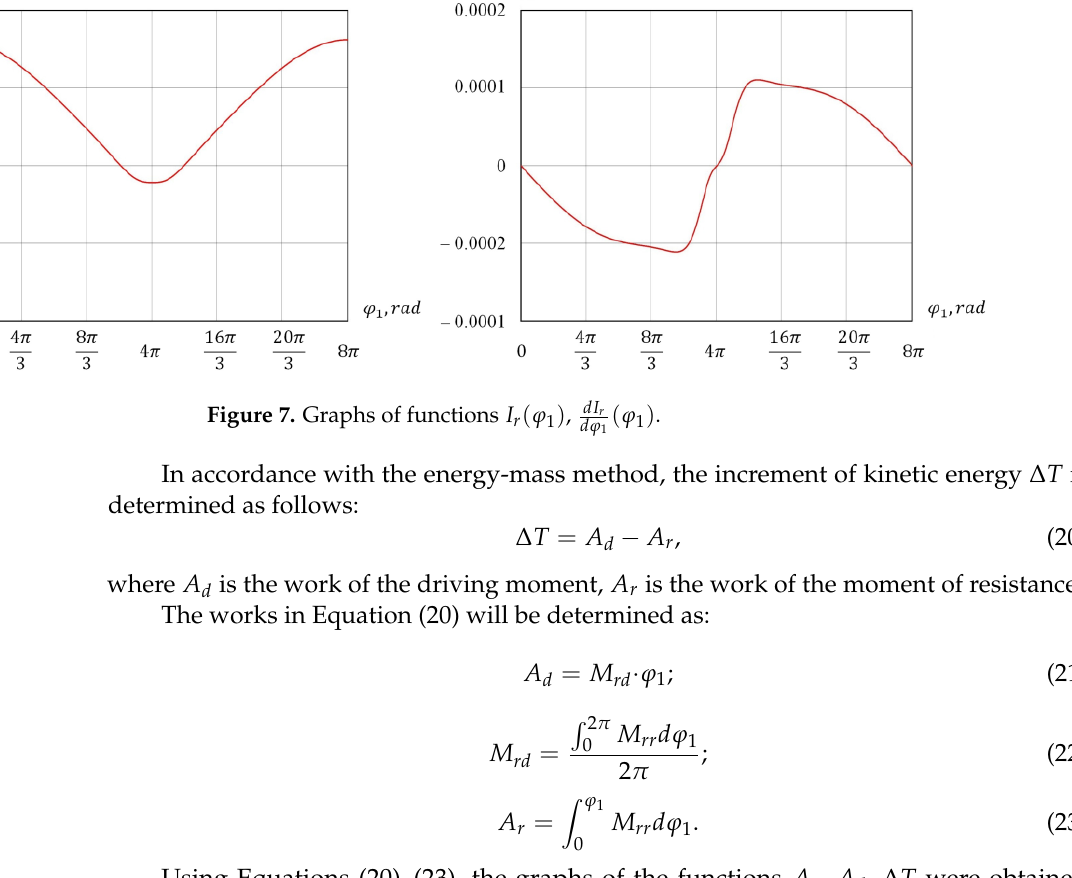
Figure 7. Graphs of functions 𝐼 (cid:3045) (𝜑 (cid:2869) ) ,